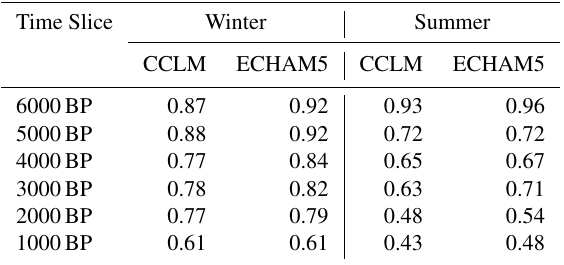
Table 2. Winter (left) and summer (right) temperature cost function estimates for the CCLM and the ECHAM5 models compared to the Proxy reconstructions for each time slice of mid-to-late Holocene. Values closer to 0 indicate a better agreement with proxy recon-